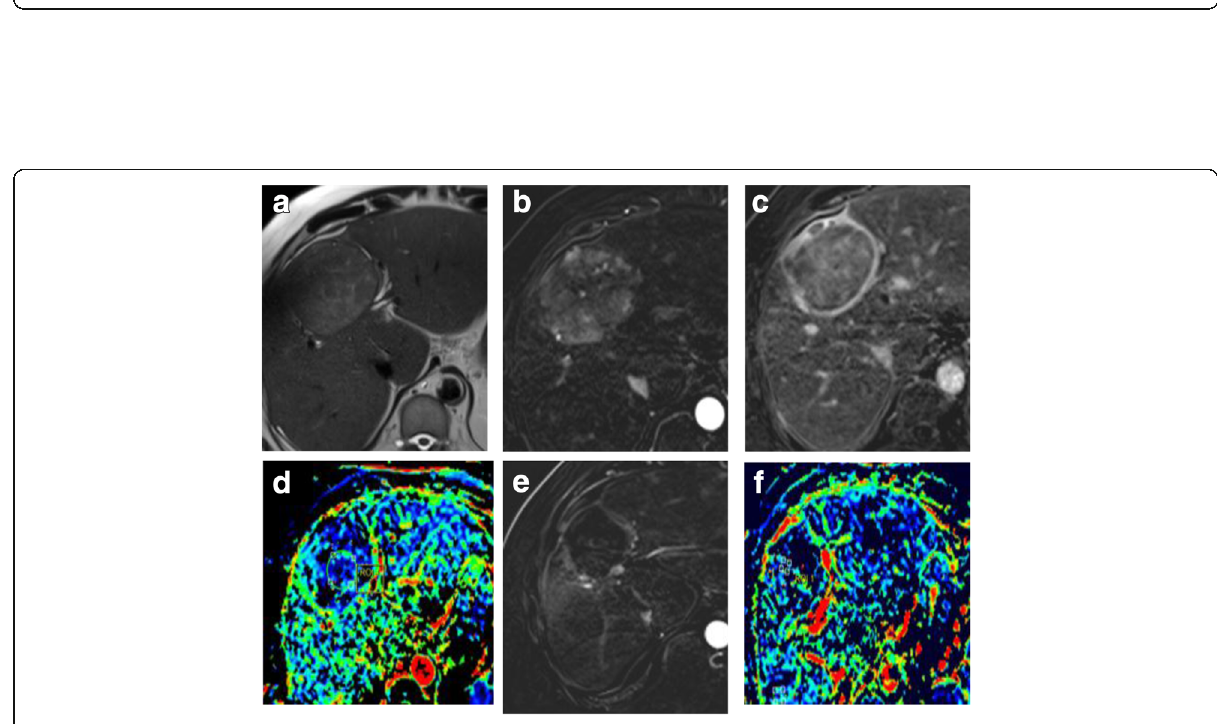
Fig. 14 Hepatic focal lesion before and after TACE with IVIM assessment. a T2-WI shows a well-defined HFL of an intermediate signal. b Subtracted enhanced T1-WI in the arterial phase shows early arterial heterogeneous enhancement. c Enhanced T1-WI in the delayed phase shows washout with delayed capsule enhancement. d F map of IVIM shows a high F value due to increased microcirculation. e Post-treatment subtracted T1-WI arterial phase shows non-enhancement of the lesion. f Post-treatment F map of IVIM shows a reduced F value due to tumor necrosis. Final diagnosis is LR-TR